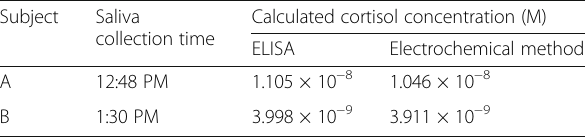
Table 1 Measurements of cortisol concentration in authentic saliva samples using ELISA and our developed electrochemical method